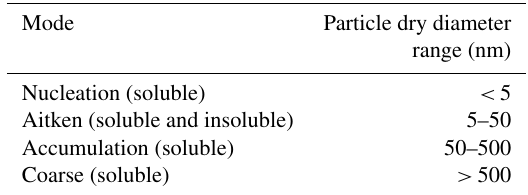
Table 1. The four modal size distributions used by GLOMAP-